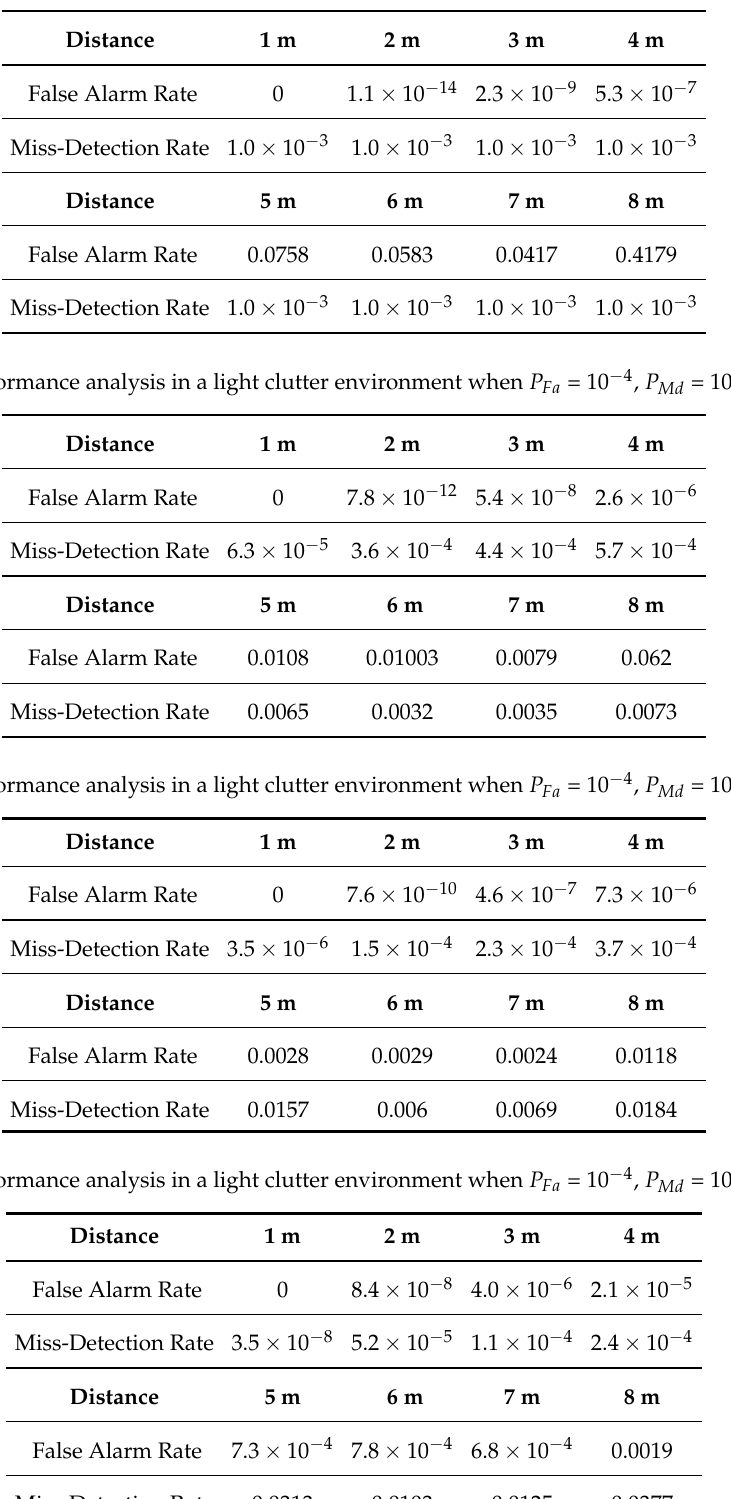
Table 1. Performance analysis in a light clutter environment when P Fa = 10 − 4 , P Md = 10 − 3 , α = 0.